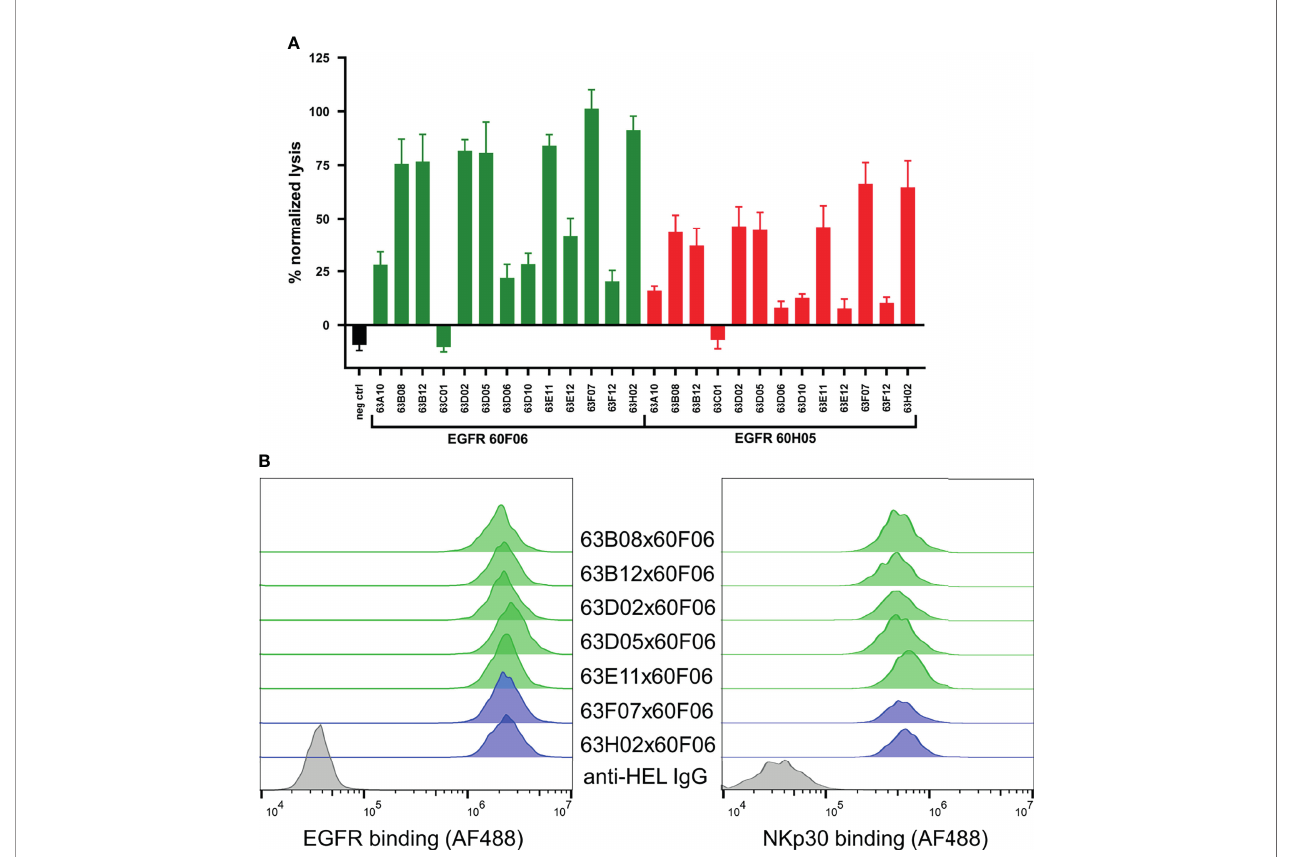
FIGURE 4 | Killing capacities of 26 generated cattle derived common light chain bispeci fi cs (A) and cellular binding ( B , left) as well as simultaneous binding to A431 and NKp30 ECD ( B , right). Fluorescence-microscopy based killing assay using EGFR-positive A431 target cells and PBMC-puri fi ed NK effector cells at an E:T ratio of 5:1 (A) as well as cattle derived bsAbs at a concentration of 50 nM. A monospeci fi c EGFR targeting Fc effector silenced negative control was included (black). Individual bsAbs based on EGFR targeting paratope 60F06 shown in green and entities based on EGFR-speci fi c binder 60H05 given in red. Data was normalized to allow comparison of the independent experiments. Graphs show normalized means ± SEM of n = 3 different healthy donors. ( B , left) Cellular binding of selected 60F06 based cattle-derived ultralong CDR-H3 common light chain bsAbs to EGFR expressing A431 cells at 100 nM. B7-H6 competing molecules shown in green, molecules targeting another epitope on NKp30 given in blue. An anti-HEL IgG control was included (grey). Cellular binding properties were detected via a fl uorophore conjugated anti-human Fc antibody ( B , right) Simultaneous binding properties of generated bispeci fi cs. A431 cells were incubated with engineered common light chain bispeci fi cs at 100 nM (green: B7-H6 competitors, blue: B7-H6 non competitors) followed by incubation with his-tagged NKp30 ECD at 200 nM. Simultaneous binding was detected via a fl uorescence-labeled anti-his